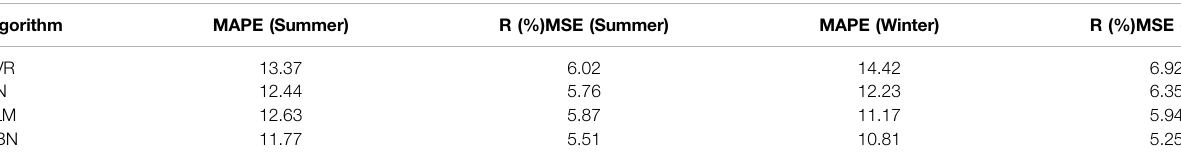
TABLE 2 | Prediction performance of all algorithms tested.